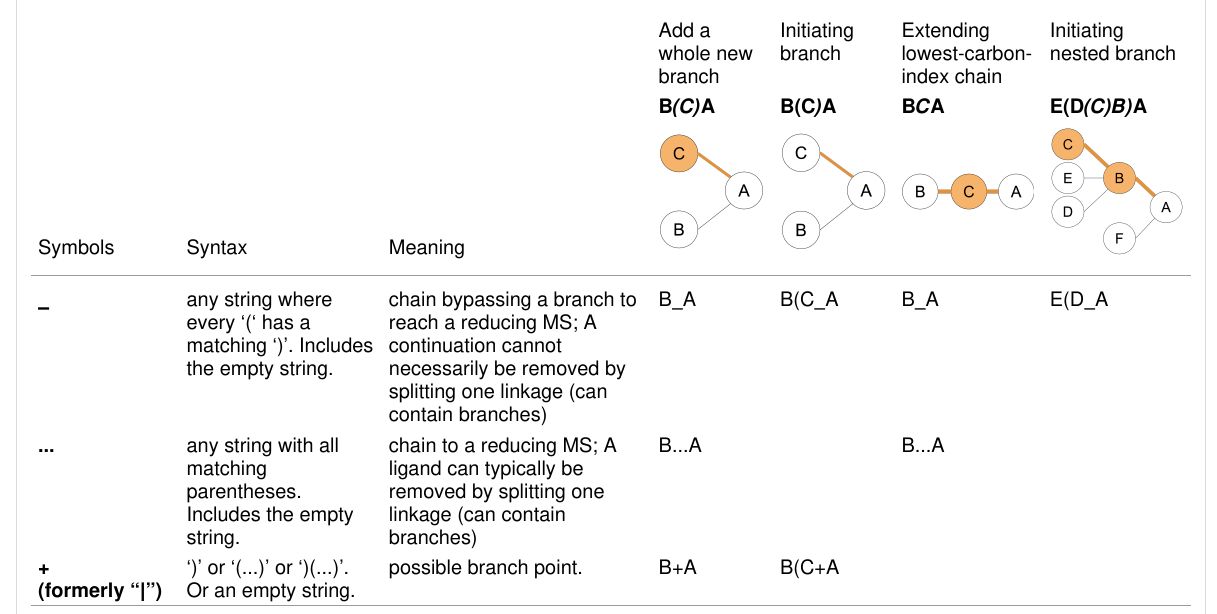
Table 6: The difference between “ _ ”, “ … ” and “ | ” with illustrations. These symbols were proposed by Krambeck et al. [10]. The initial names are ligand (“ ... ”), continuation (“ _ ”), and possible branch (“ | ”). Each uncertainty operator in the last four example columns can be replaced by the substring in red to achieve the behavior described in the column header. For a more comprehensive look at the usage of these uncertainty operators, see Supporting Information File 1, Table S1 for a manual collection of matches, and Table S4 (Supporting Information File 1) for an automated collec- tion of matches.